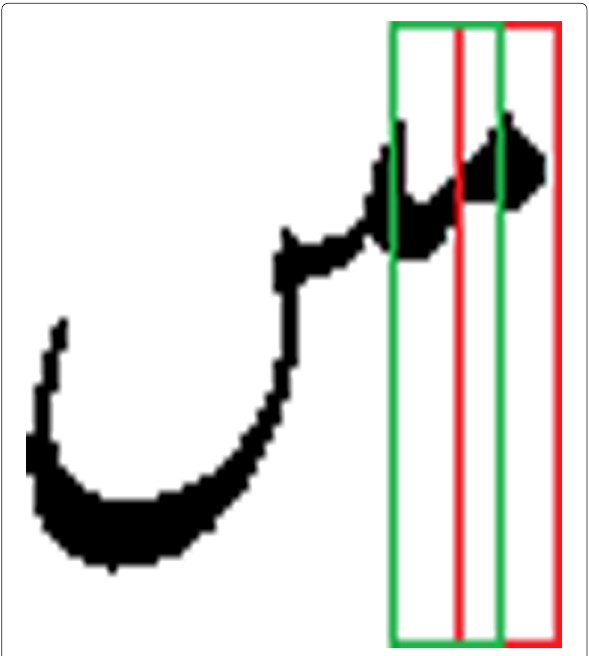
Fig. 8 A sample Urdu ligature with overlapped sliding